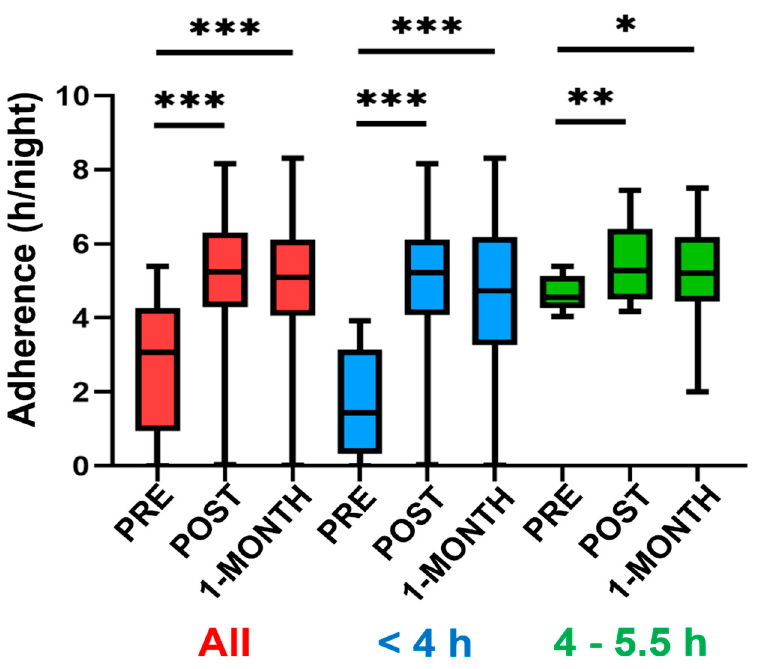
Figure 2. Adherence of CPAP is expressed as the number of hours per night on treatment (median, 25–75% percentiles and smallest and largest values). Data are shown for the whole group of patients (red), for those patients with preintervention (PRE) adherence of <4 h/night (blue), and for those with preintervention adherence between 4 and 5.5 h/night (green). Labels “POST” and “1-MONTH” indicate values measured immediately at the end of the intervention and 1 month later, respectively. All changes from PRE to POST and from PRE to 1-MONTH were statistically significant, and none of the minor changes from POST to 1-MONTH were statistically significant. ***, **, and * indicate p < 0.001, p < 0.01 and p < 0.05, respectively.